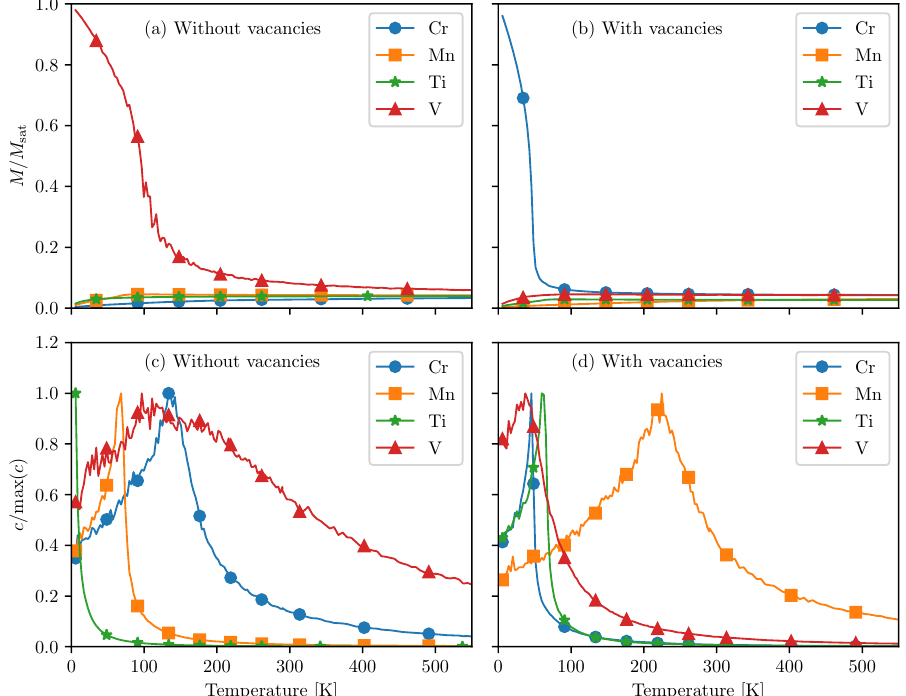
Figure 3. ( a ) The magnetization of intercalated PtSe 2 for various intercalants without any vacancies. M is the magnetization per intercalant atom obtained from the MC simulations and M sat is the saturation magnetization. ( b ) The magnetization of intercalated PtSe 2 for various intercalants in the presence of vacancies. ( c ) The specific heat c of intercalated PtSe 2 for various intercalants without any vacancies. ( d ) The specific heat c of intercalated PtSe 2 in the case where vacancies are